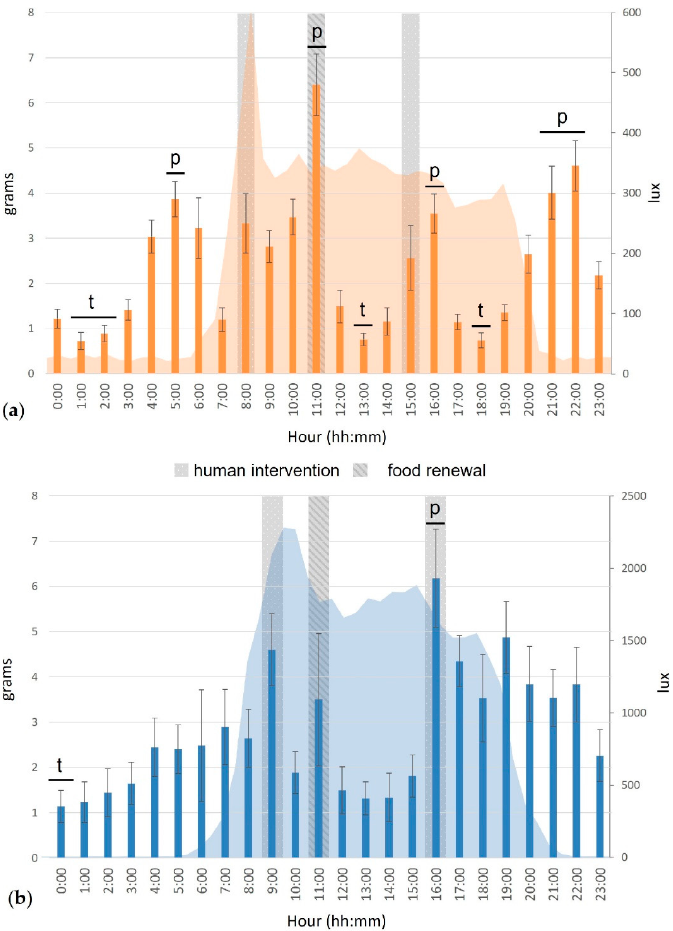
Figure 11. Mean food consumption (g, bars) and luminosity (lux, area) during a day cycle of the cats, indoors ( a , n = 15) and outdoors ( b , n = 8). Error bars represent standard errors, (p) indicates a significant peak, (t) indicates a significant trough (for more details, see [29]). The outdoor cats ate significantly more than the indoor cats at 07:00, 09:00 (during the first outdoor human intervention) and from 16:00–20:00 (Figure 12). The indoor cats ate significantly more than the outdoor cats at 10:00 and at 11:00, when food was renewed (Figure 12).